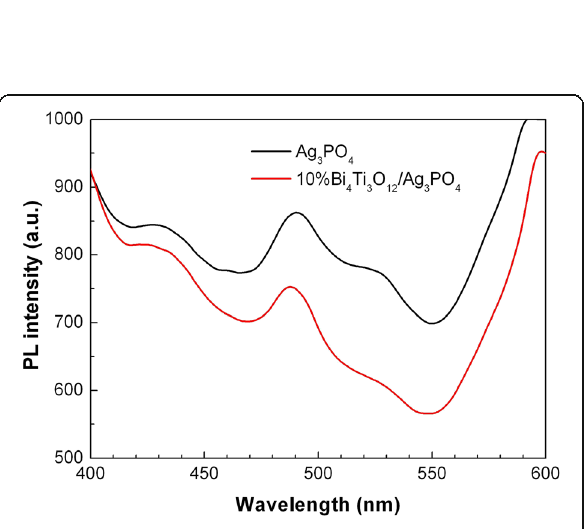
Fig. 7 PL spectra of Ag 3 PO 4 and 10% Bi 4 Ti 3 O 12 /Ag 3 PO